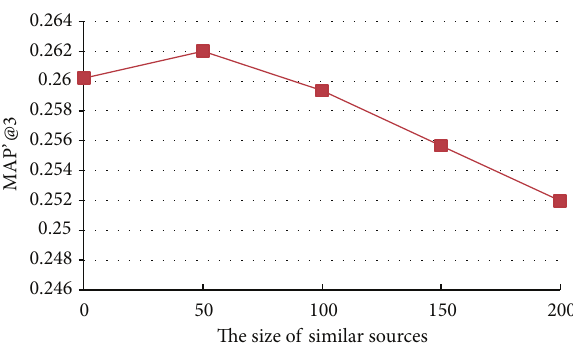
Figure 7: Impact of size of similar sources on accuracy of Seeker source n 2